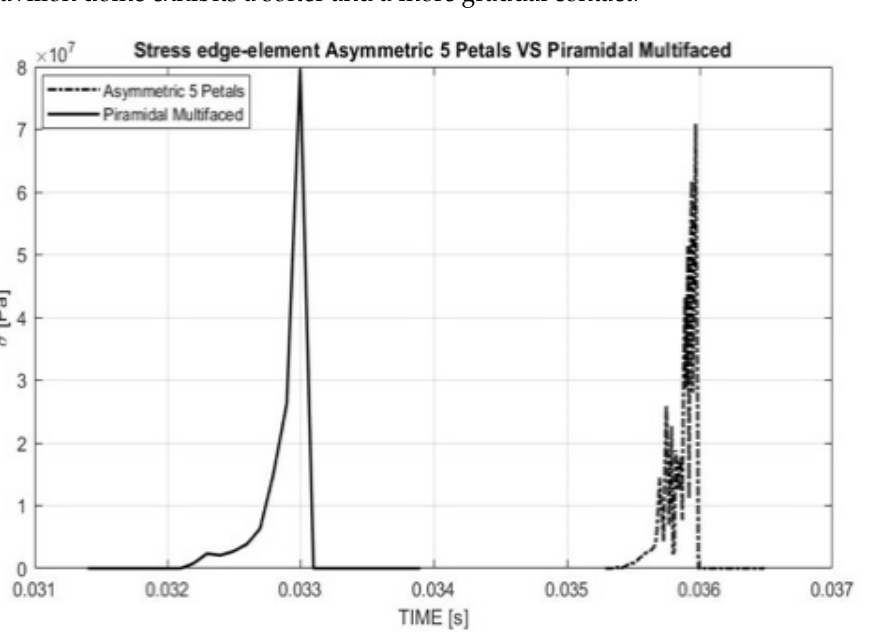
Figure 17 . Planar VS Pyramidal Multifaced Tailgate: Stress evaluation. Figure 17. Planar VS Pyramidal Multifaced Tailgate: Stress